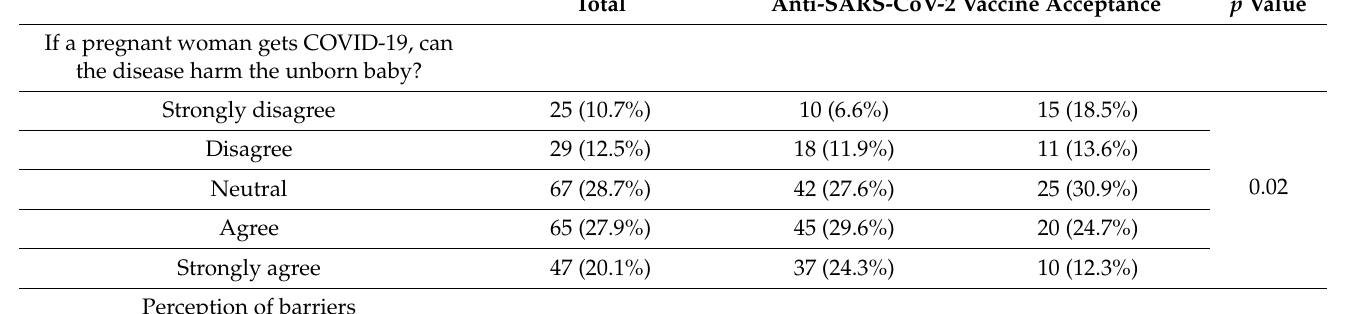
Table 2. Cont. Total Anti-SARS-CoV-2 Vaccine Acceptance p